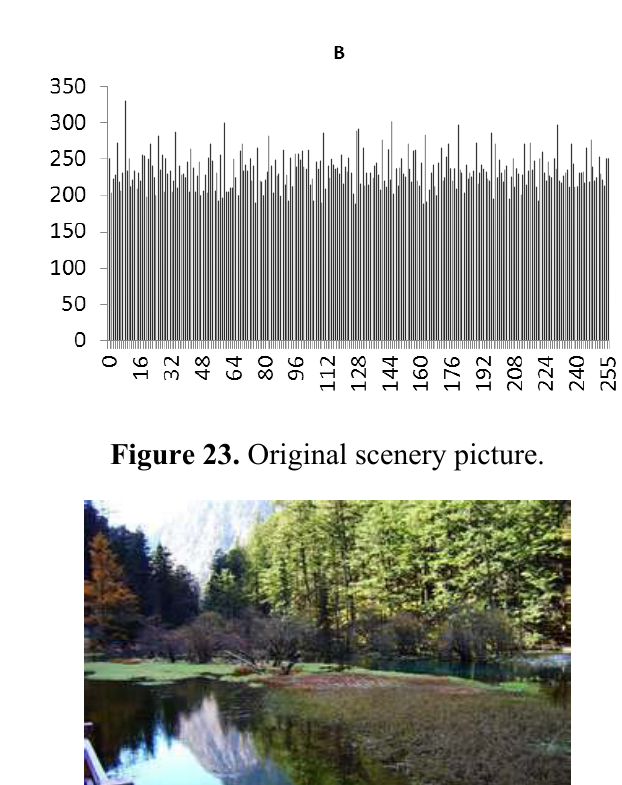
Figure 22. Statistical chart of B value distribution after encryption.